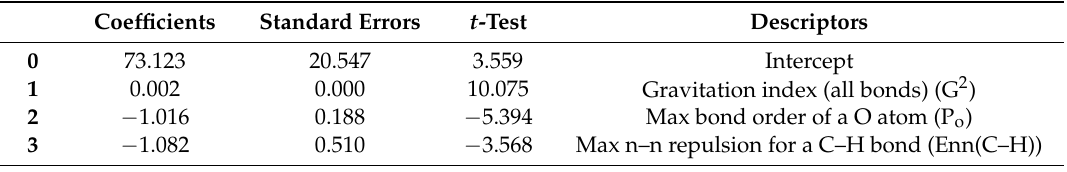
Table 2. Descriptors, Coefficients, Standard Error, and t -Test Values for the Best MLR Model of Group